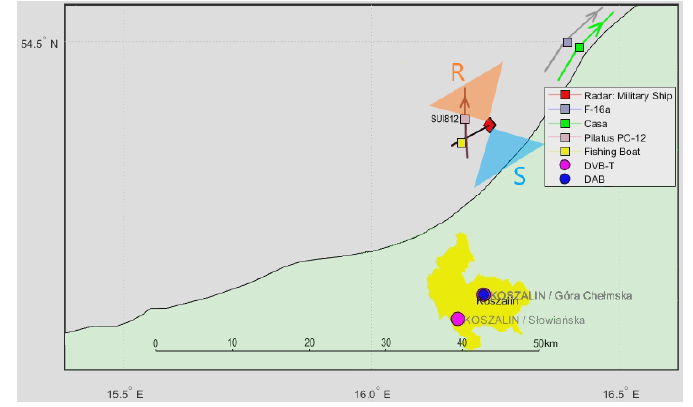
Figure 18. Situation map with the cooperative aircraft and fishing boat.